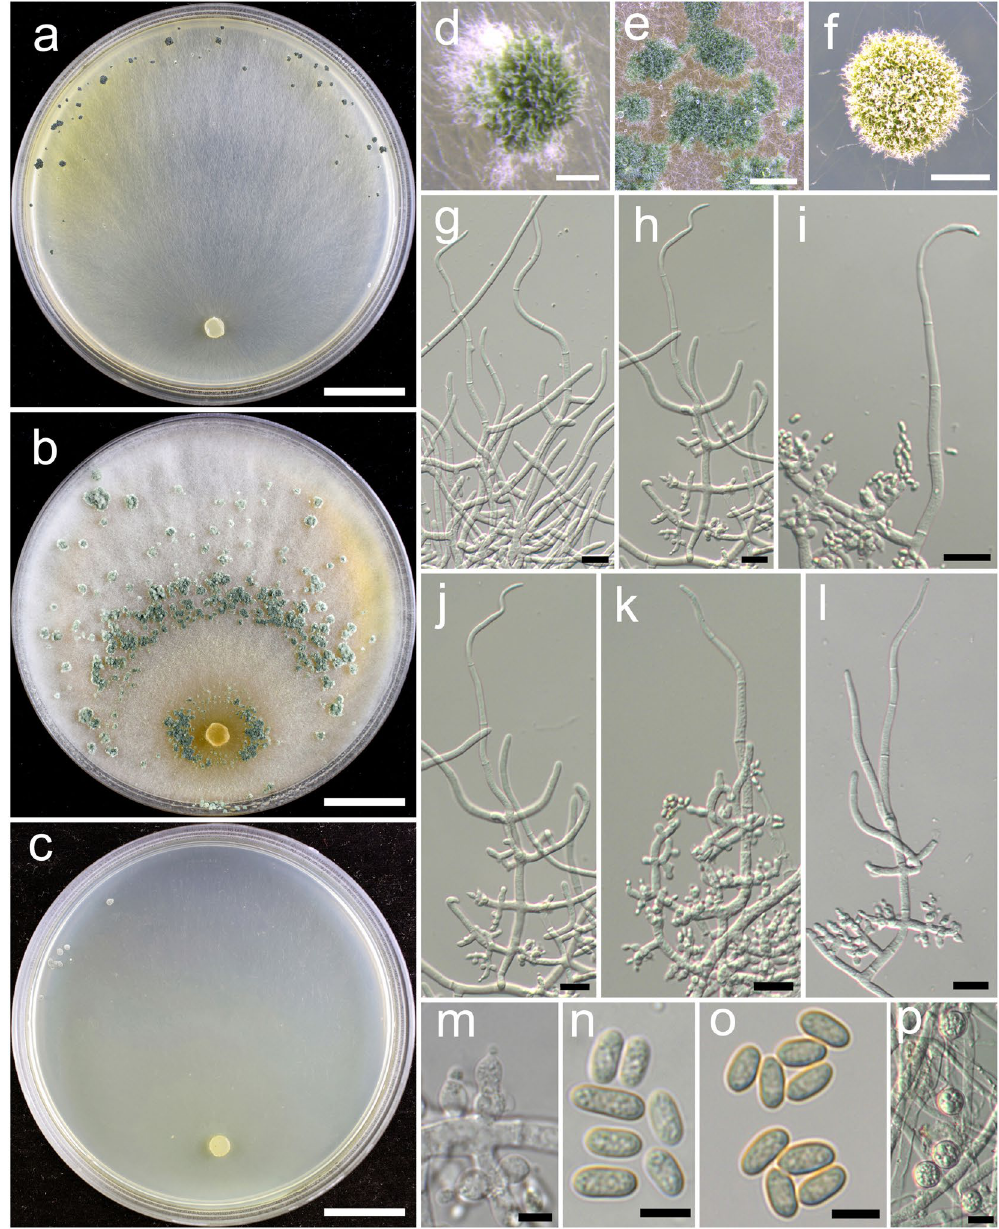
Figure 18. Trichoderma longisporum (HMAS 248843). ( a – c ) Cultures at 25 °C, 10 d (a. on CMD; b. on PDA; c. on SNA); ( d , f ) Conidial pustules (d. CMD, 10 d; e. PDA, 10 d; f. SNA, 10 d); ( g – m ) Conidiophores and phialides (PDA, 10 d); ( n – o ) Conidia (PDA, 10 d); ( p ) Chlamydospores (PDA, 19 d). Bars: a–c = 20 mm. d = 300 μ m. e = 800 μ m. f = 600 μ m. g–l = 20 μ m. m–o = 5 μ m. p = 10 μ